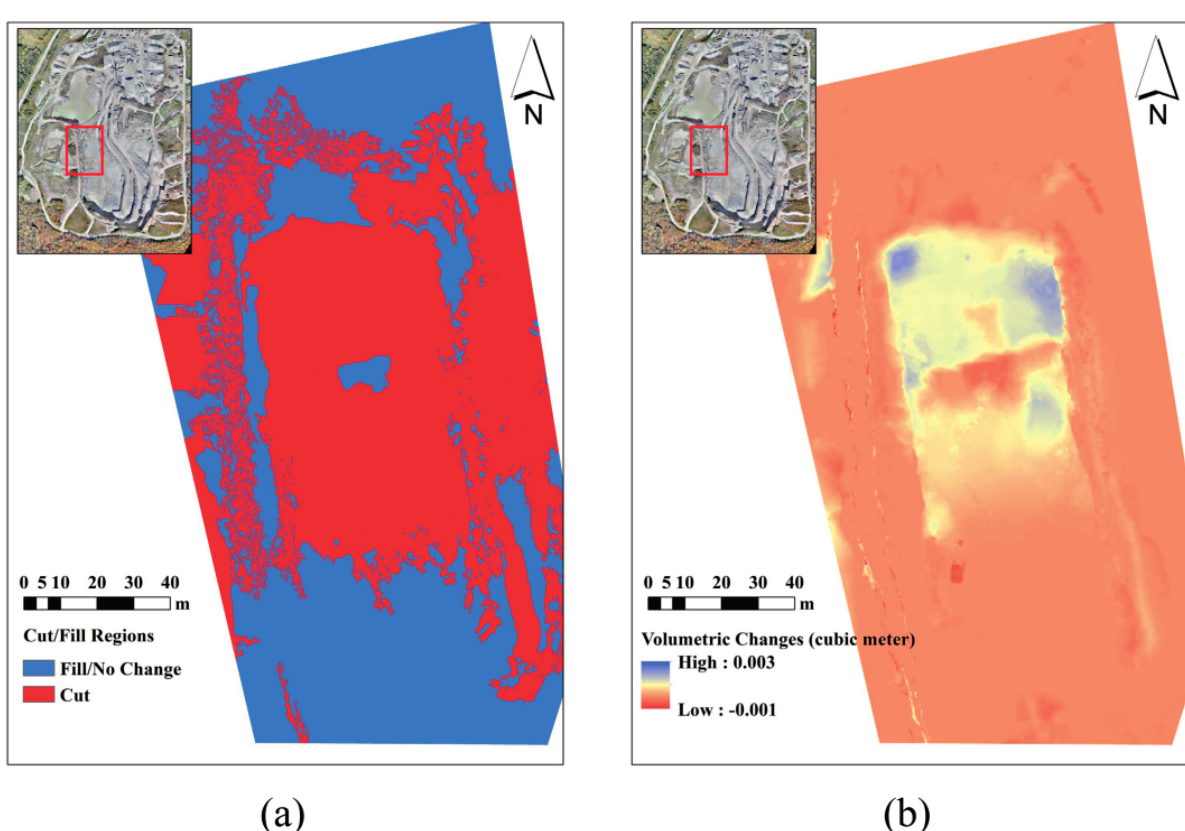
Figure 26. ( a ) Cut/fill regions; ( b ) Volumetric change